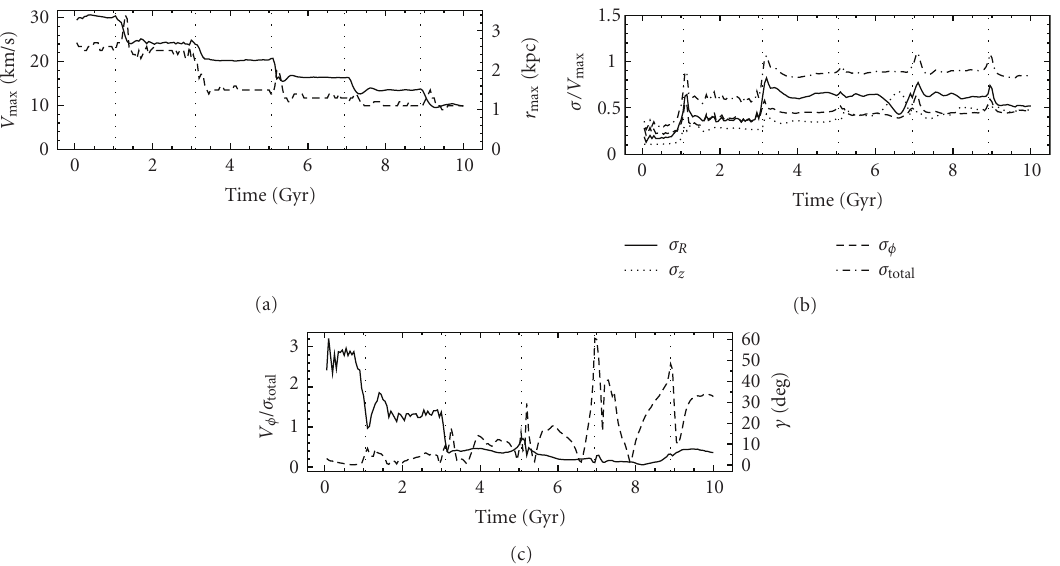
Figure 3: Evolution of structural parameters of a tidally stirred dwarf in a high resolution numerical simulation. The plot shows the results for one of the models studied by Klimentowski et al. [39], whose initial disk was oriented at 90 degrees with respect to the orbital plane (this is a conservative case since other orientations leave almost no residual angular momentum, see text in Section 3). Upper panel: the maximum circular velocity (solid line, left axis) and the radius at which the maximum circular velocity occurs (dashed line, right axis). Middle panel: the velocity dispersion (total 3D, and 1D along three di ff erent cylindrcal axes) expressed in units of the maximum circular velocity (indicated as V peak in the text). Lower panel: evolution of the ratio of the mean rotation velocity to the total (3D) velocity dispersion and the angle γ between the total angular momentum vector of the stars and the orbital plane (dashed line, right axis).In all panels vertical dotted lines indicate pericentre passages. Loss of angular momentum due to tidally induced instabilities and simultaneous increase of stellar velocity dispersion owing to tidal heating lead to a low v/σ ratio comparable to that of dSphs. See Klimentowski et al. [39] for details on how internal angular momentum is